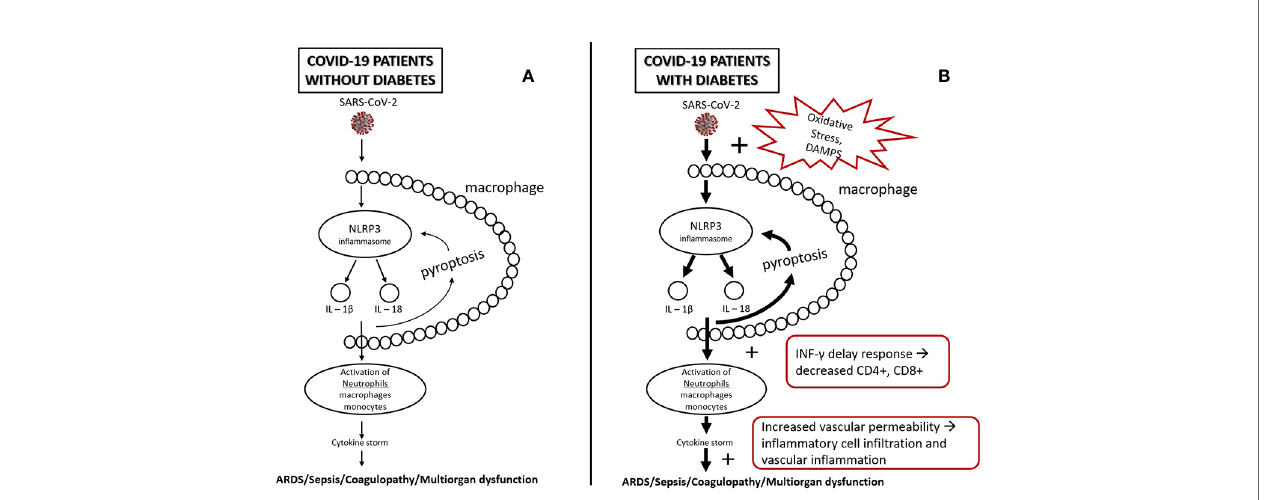
FIGURE 1 | (A) SARS-CoV-2, after infection, triggers NLRP3 in fl ammasomes of alveolar macrophages. NLRP3 activation leads to a release of IL-1 b , IL-18, and pyroptosis which, in turn, triggers in fl ammasome and leads to activation of other immune cells (e.g., neutrophils, lymphocytes, monocytes). This may initiate a cascade of secretion of proin fl ammatory cytokines (cytokine storm), leading to tissue injury and multiorgan failure. (B) In diabetes, oxidative stress and DAMPS (Damage-Associated Mollecular Patterns) overactivate in fl ammasomes leading to a state of low-grade in fl ammation and a more intense secretion of proin fl ammatory cytokines. Low-grade in fl ammation leads to a delay of INF- g response, lymphopenia, and greater accumulation of in fl ammatory macrophages and monocytes, which, in combination with the increased vascular permeability and damaged glycocalyx, may increase the risk for tissue injury and multiorgan